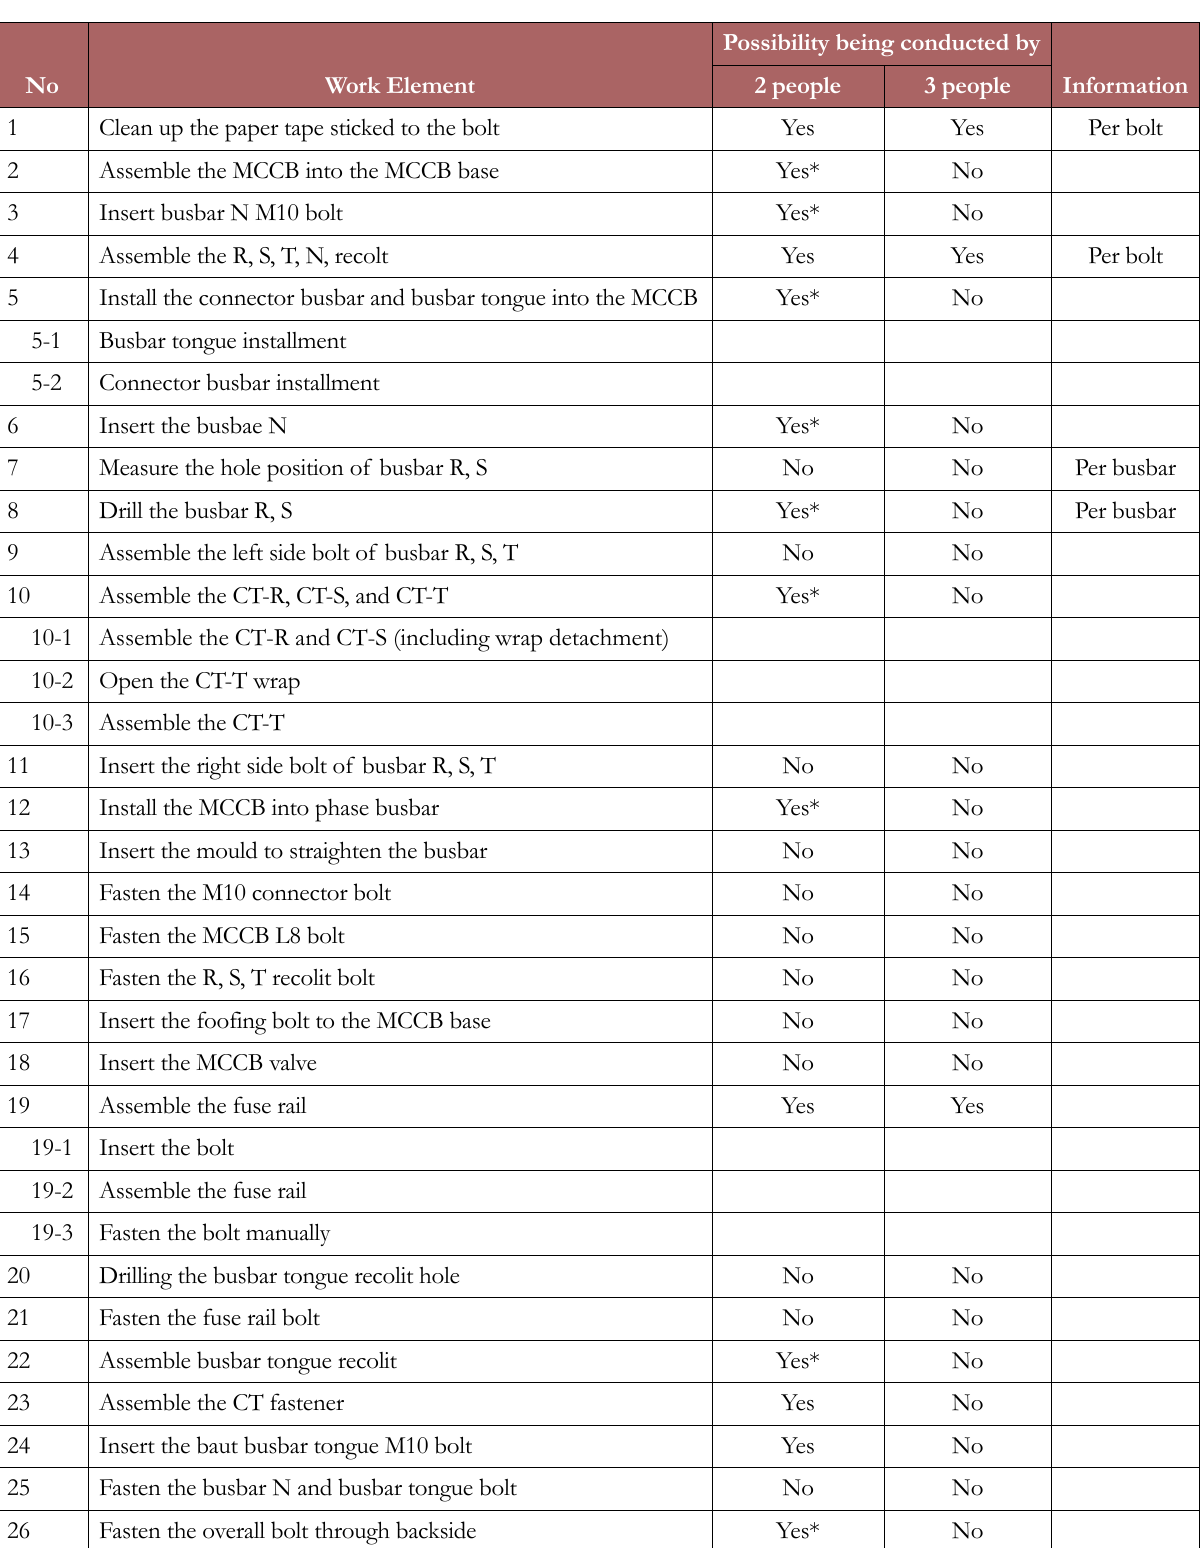
Table 7. Check List of the Work Element that Enabling the Accomplishment Using 2 or 3